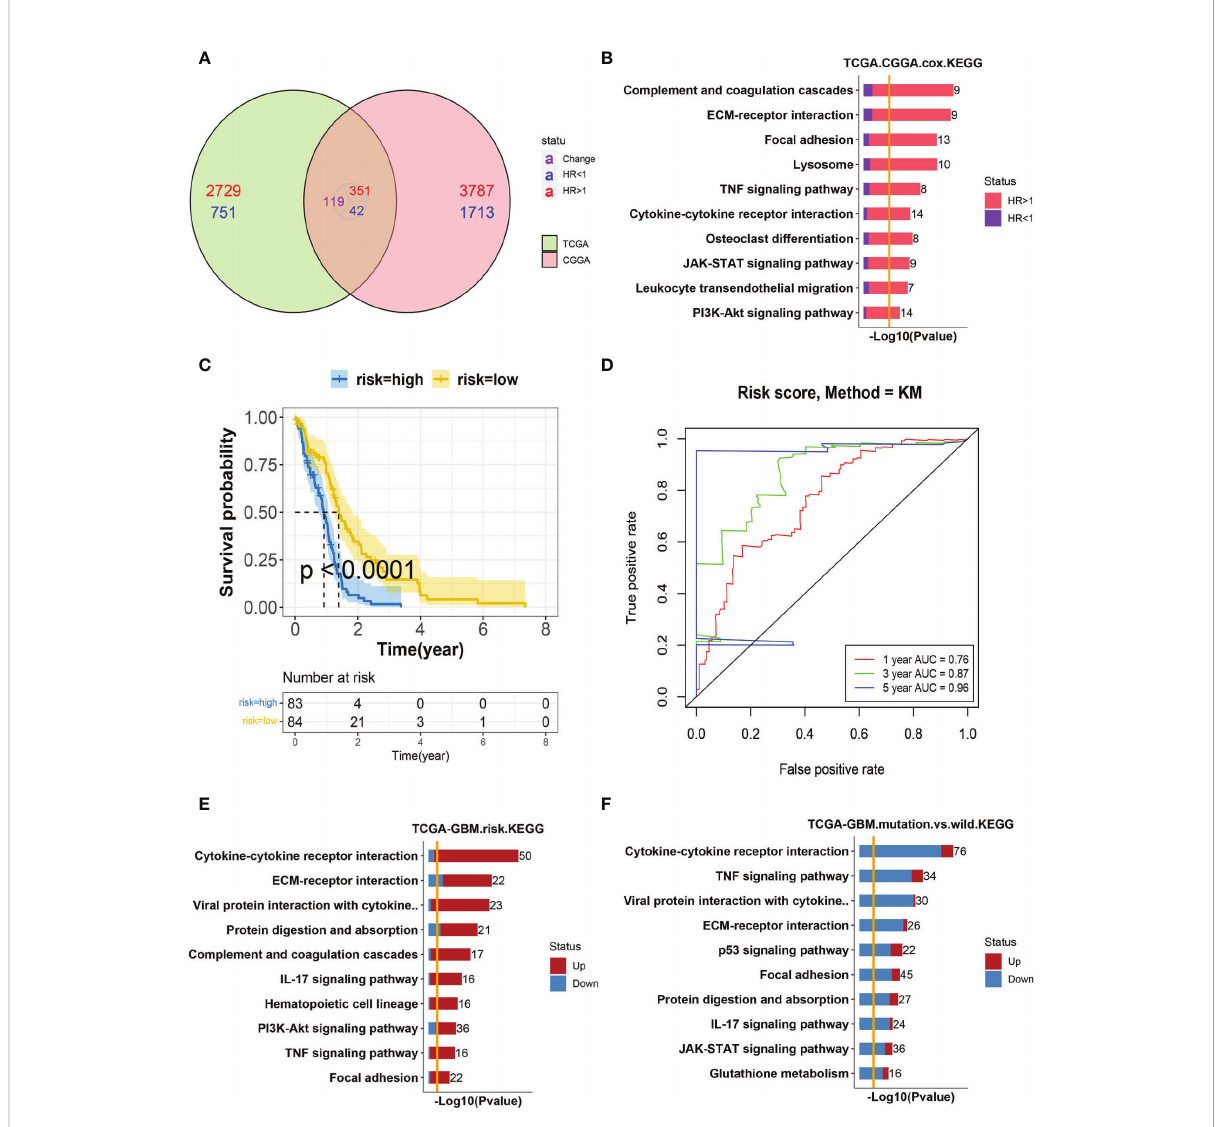
FIGURE 1 Analysis of GBM progression-related pathways (A) The Venn diagram of survival-related genes in the TCGA – GBM and CGGA cohorts. A total of 86 genes were found to coexist with diversity, of which 81 genes were associated with a poor prognosis. (B) Bar-plot of KEGG enrichment analysis of 86 survival-related genes with x-axis as − log10 transformed P-value. Bars were colored by the ratio of poor and good prognosis-related genes. (C) The Kaplan – Meier curves comparing patients with a low- or high-risk score in the TCGA – GBM cohort. Patients were divided into two groups according to the median value of their risk scores. Higher risk scores were correlated with a poorer prognosis. (D) ROC curve for the risk model in the TCGA – GBM cohort. (E) Bar-plot of KEGG enrichment analysis of DEGs between high- and low-risk groups. Bars were colored by the ratio of up and downregulated genes. Upregulated genes were those with elevated expression in the high-risk group. (F) Bar-plot of KEGG enrichment analysis of DEGs between mutant and wild-type patients. Bars were colored by the ratio of up and downregulated